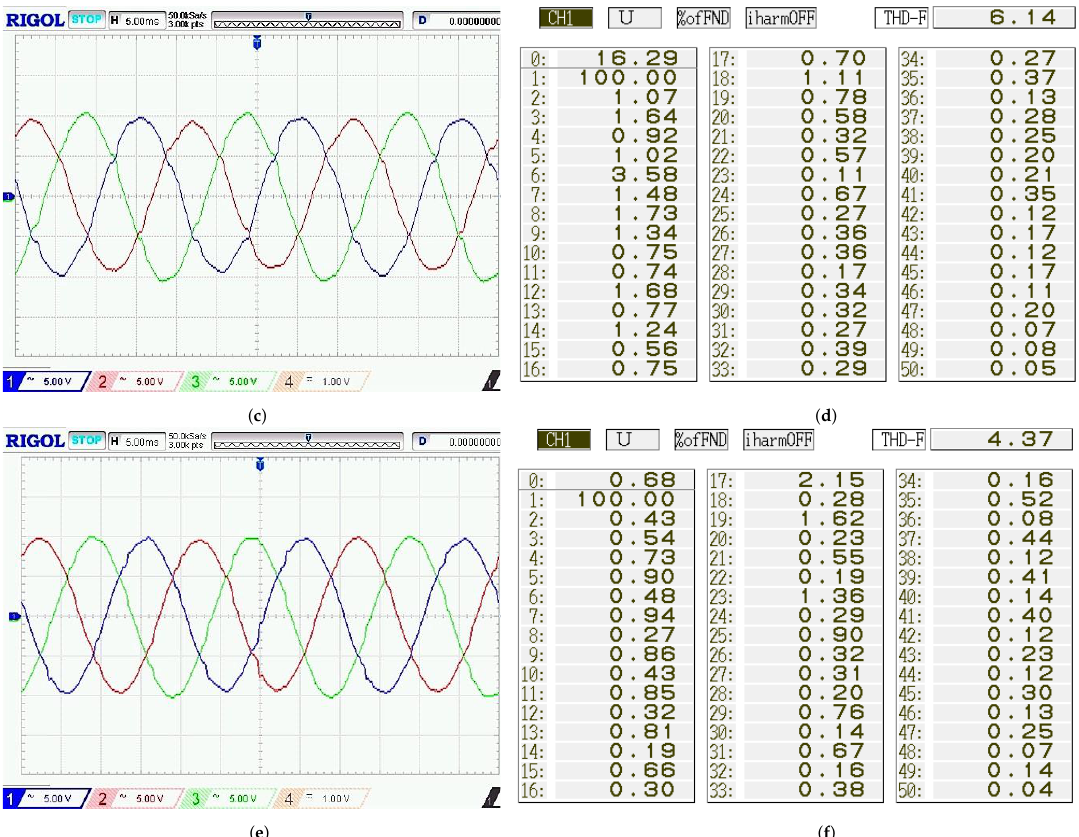
Figure 12. ( a ) Output voltage waveforms for experiment 1. ( b ) THD for experiment 1. ( c ) Output voltage waveforms for experiment 2. ( d ) THD for experiment 2. ( e ) Output voltage waveforms for experiment 3. ( f ) THD for experiment